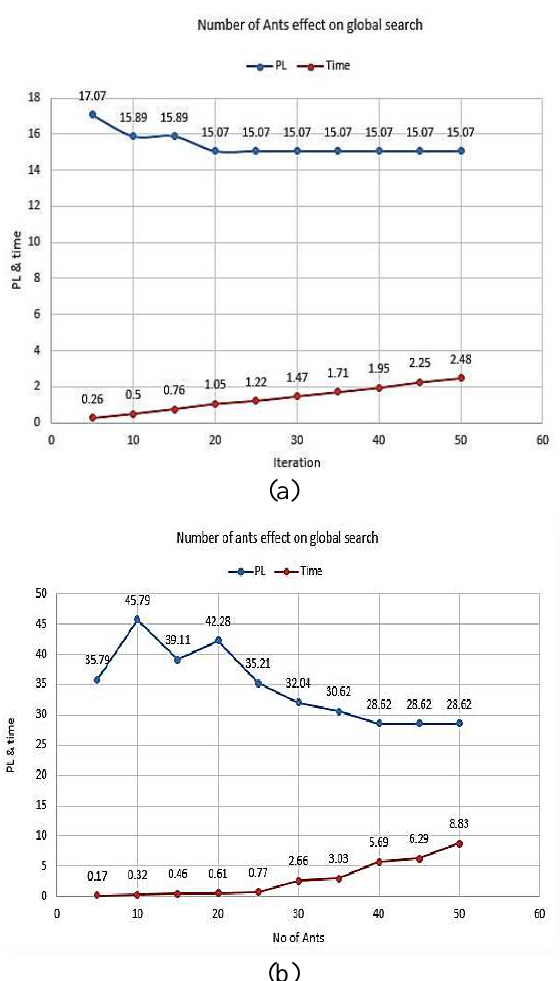
Fig. 8. Effect of no of ants on path length and execution time for (a) 10 × 10 map, and (b) map.